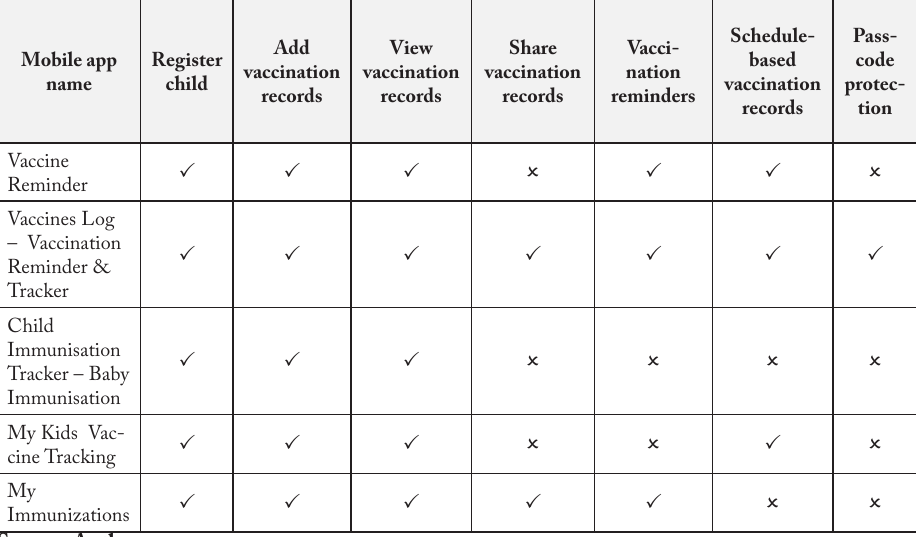
Table 2: Main features of investigated mobile applications Mobile app